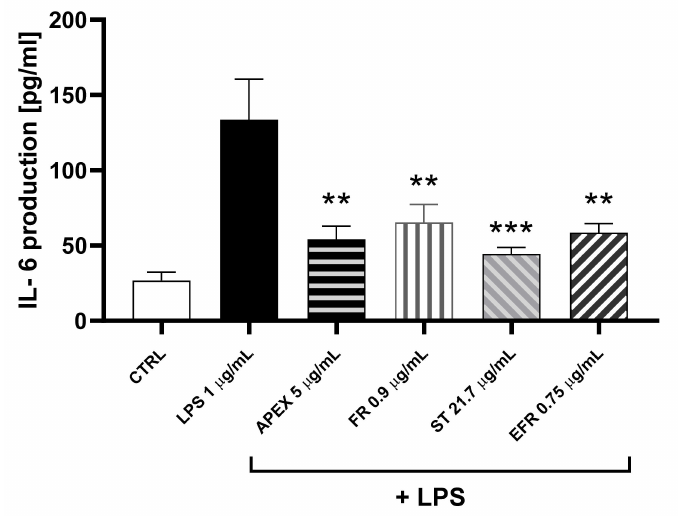
Figure 8. Effect of APEX and its major components on IL-6 protein levels. U937 cells were preincu- bated for 24 h with APEX, FR, ST e EFR; at the end of the 24 h, 1 µ g/mL LPS was added and cells incubated for a further 12 h. IL-6 levels were determined after 24 h growth in drug-free medium by ELISA assay. Results are expressed as µ g/mL of medium. Values represent the means ± SEM (n = 3). One-way ANOVA was used to measure the significance of differences between groups. *** p < 0.001 LPS vs. APEX- and ST-treated cells or control vs. LPS vs. FR- and EFR-treated cells ** p < 0.01.